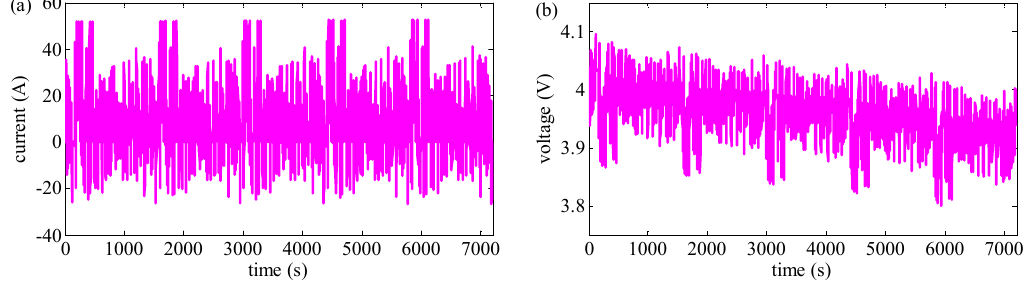
Figure 3. The measured profiles of the FUDS cycles: ( a ) current; ( b )